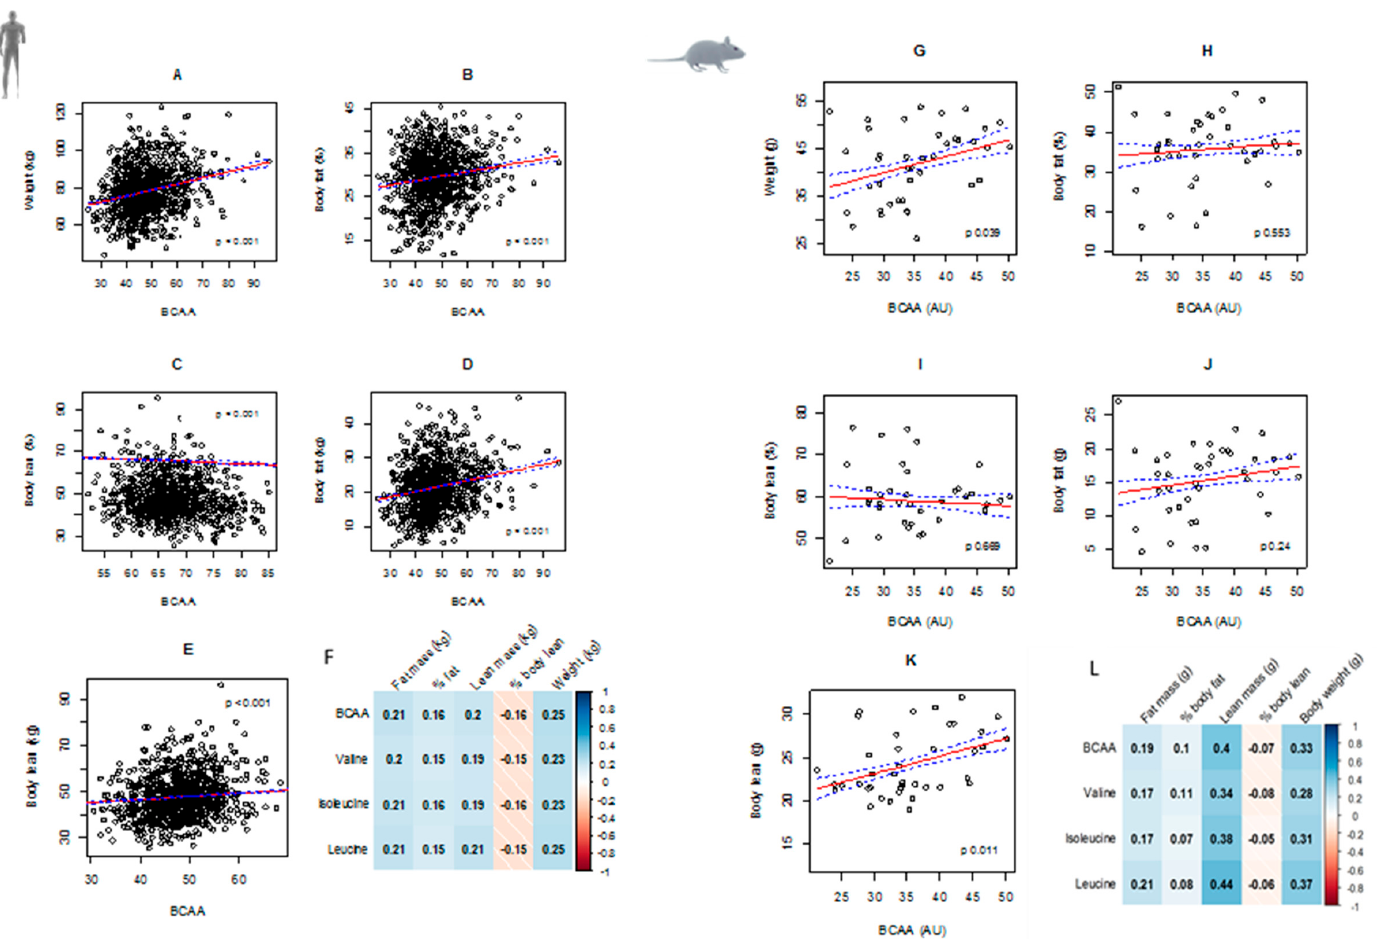
Figure 1. Circulating branched chain amino acids (BCAAs) and body composition in older men and mice. Red lines represent fitted values and blue dotted lines represent 95% confidence intervals. Body weight (kg), body fat (% and kg), and body lean (% and kg) were significantly associated with circulating BCAAs in men ( A – F ) and mice ( G – L ). Correlation matrices show similar results in both men ( F ) and mice ( L ): Energy, protein, and fat intake passively correlated with BCAAs whereas carbohydrate negatively correlated with BCAAs.